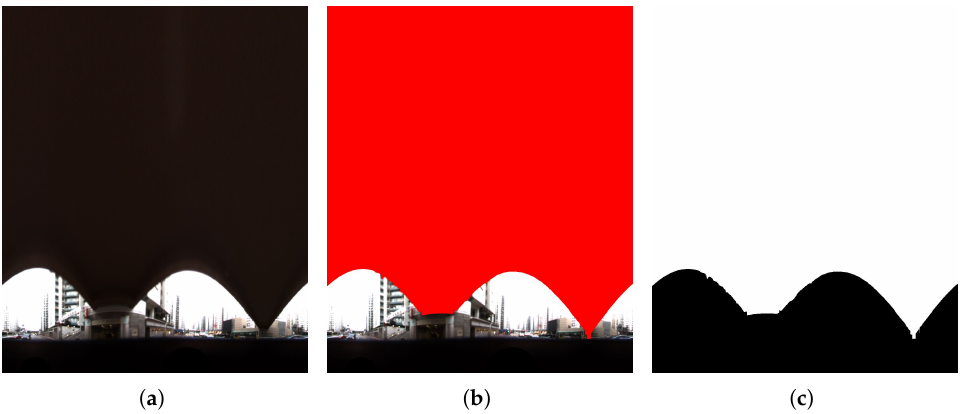
Figure 7. The results of sky region detection when there is a flyover blocking the field of view of the camera. ( a ) Image after rectification. ( b ) The algorithm incorrectly identifies the flyover region as the sky region. ( c ) The wrong result in the binarized image.